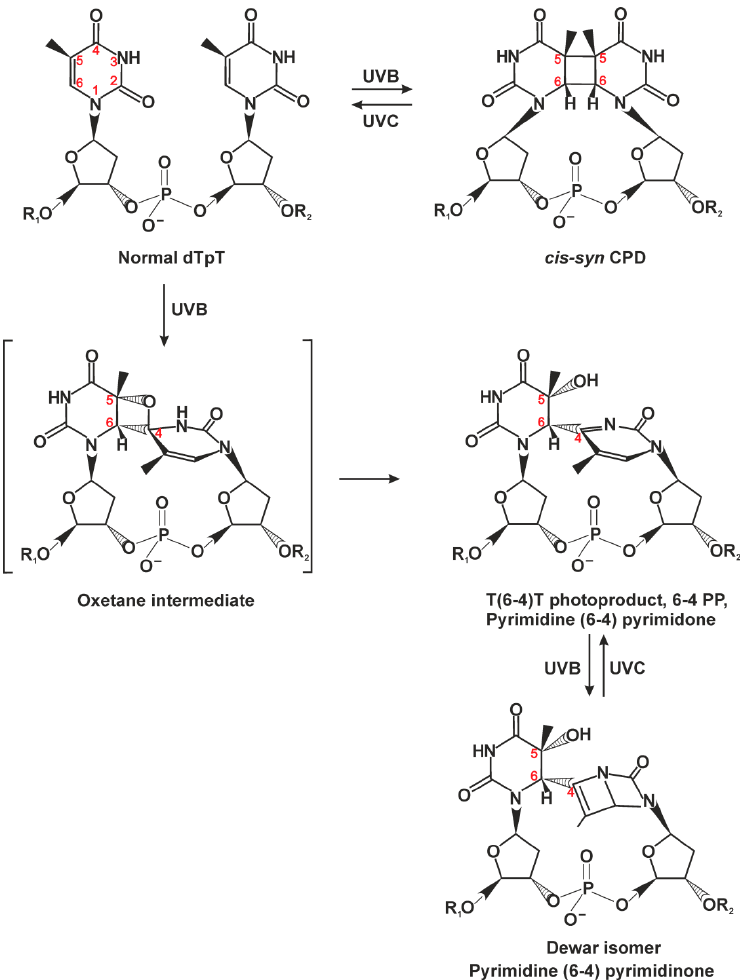
Figure 1. Chemical structures of DNA photoproducts caused by sunlight. The majority of cyclobutane pyrimidine dimers (CPDs) is formed between adjacent thymine residues (TT) but can eventually arise between adjacent T and C, C and T, or C and C, depending on the wavelength, irradiation dose, and adjacent sequences. CPD can be formed with cis-syn isomer representing large majority of CPDs within duplex DNA, and trans-syn occurring exclusively within single-stranded DNA. Pyrimidine-(6-4)-pyrimidone photoproducts (6-4PPs) are generated preferentially in nucleotide pairs TC, CC, and TT, with the ratio and yields depending on irradiation wavelength and adjacent sequences [8]. This figure is based on several studies [8,22].